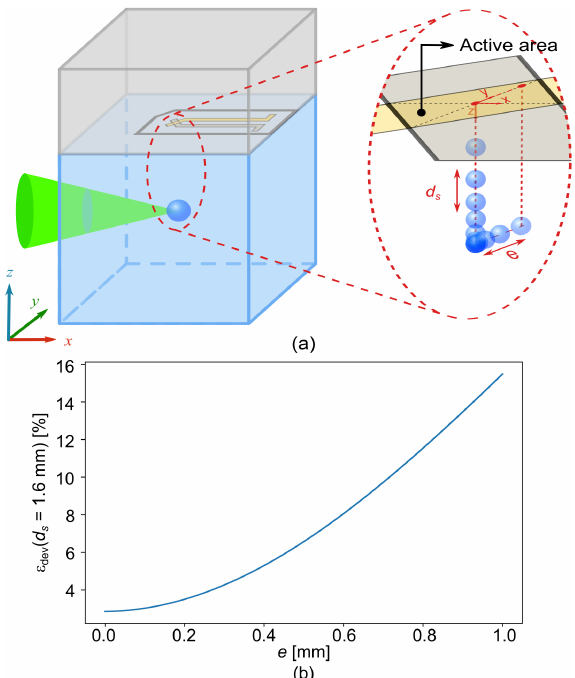
Figure 11. ( a ) Schematic of the bubble center and the PVDF active zone relative position. ( b ) Error in pressure due to the deviation ε dev with a constant standoff distance d s = 1.6mm for different deviation distance e